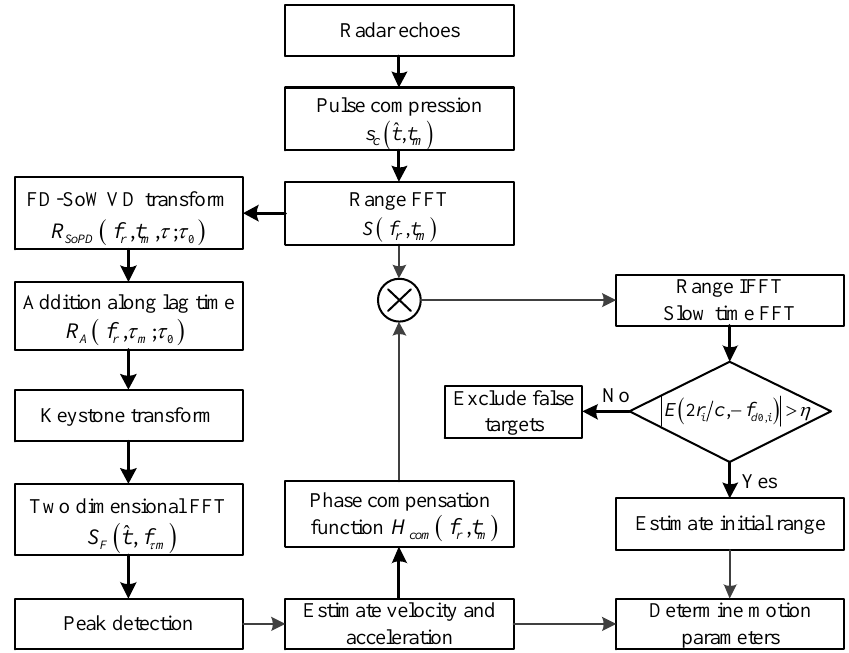
Figure 4. Flowchart of the proposed coherent detection algorithm.